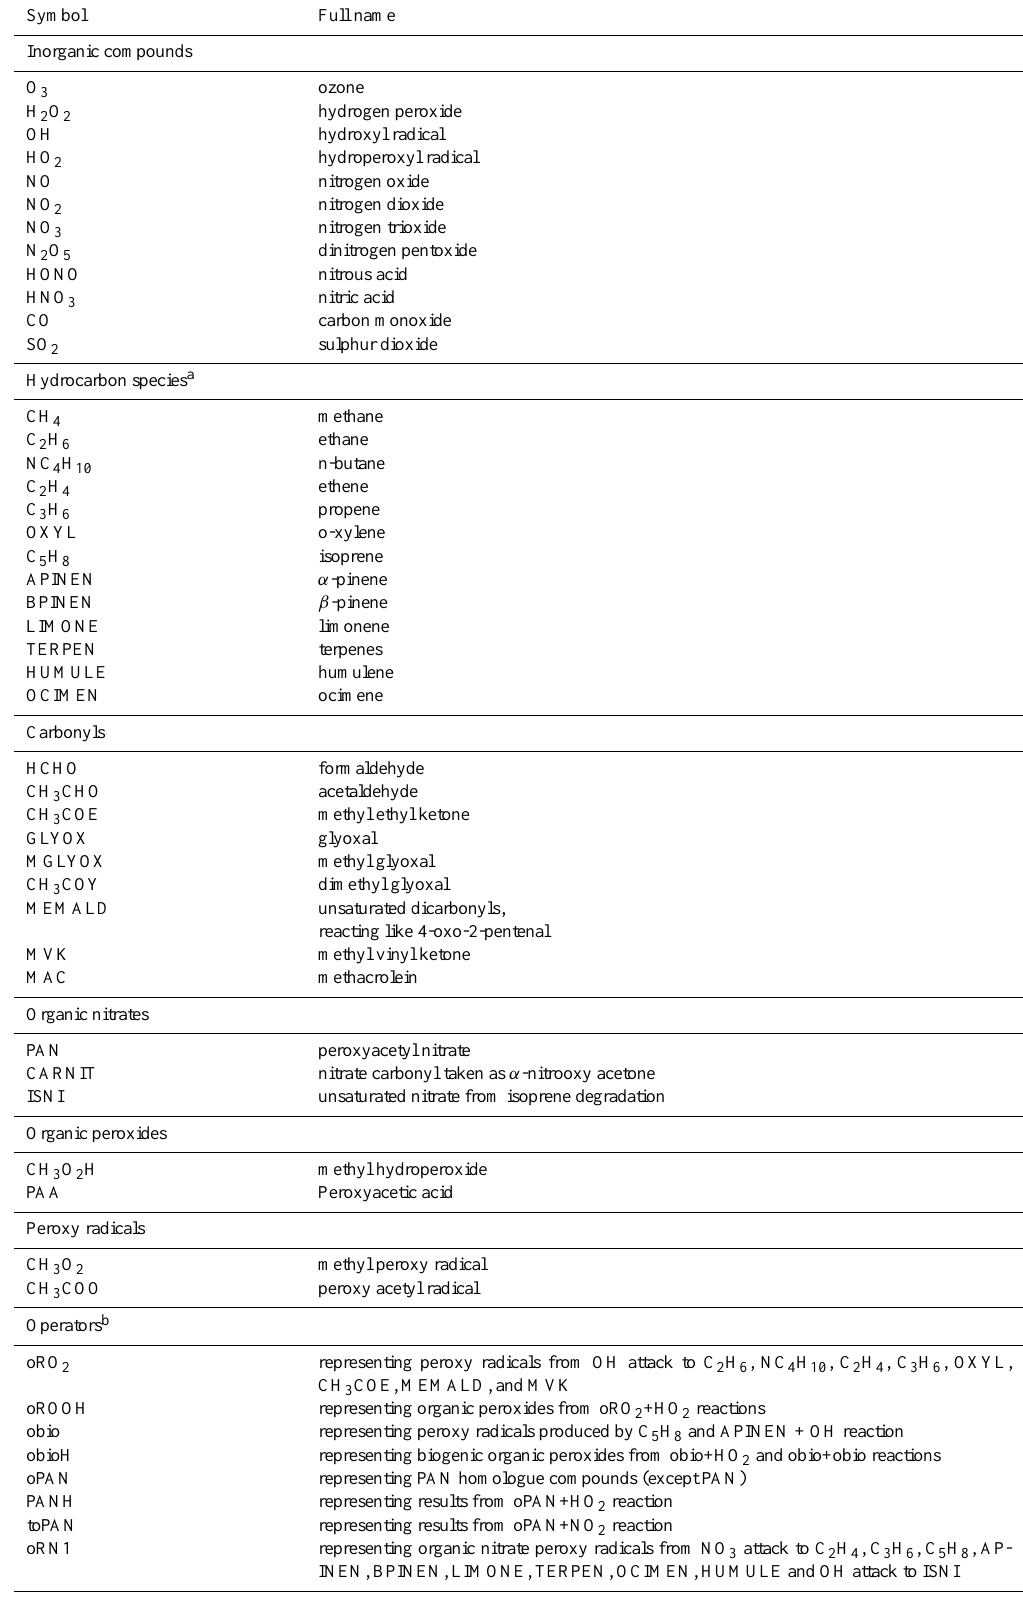
Table A1. Species list of the reduced MELCHIOR2 gas-phase chemical mechanism.